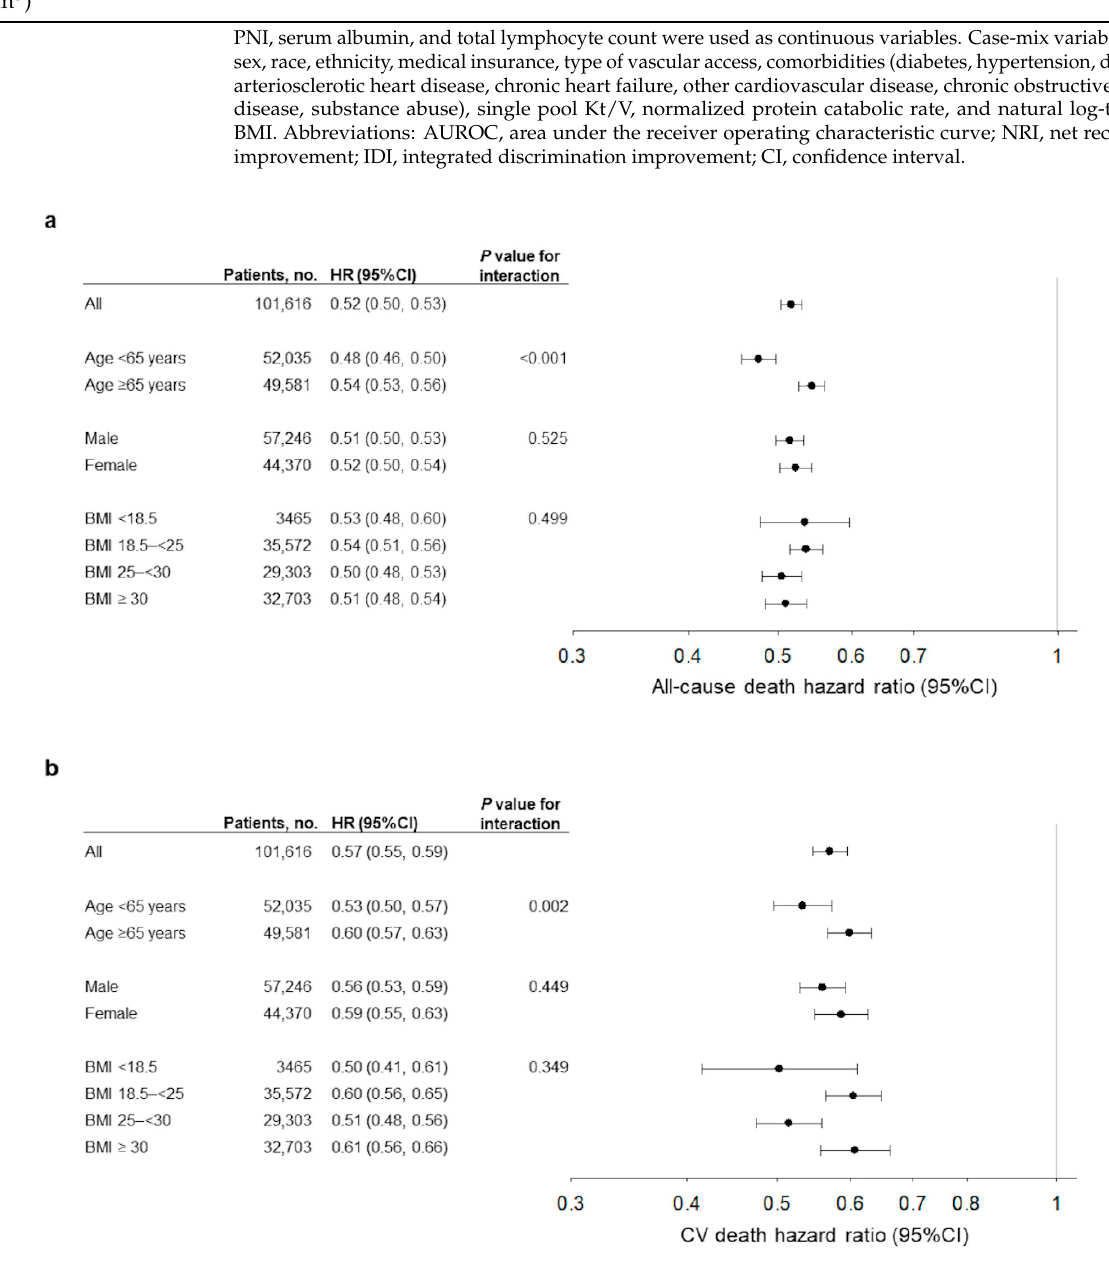
Figure 4. Association of prognostic nutritional index (PNI) with all-cause ( a ) and cardiovascular mortalities ( b ) in the subgroup analysis. Hazard ratios for mortality in the case-mix-adjusted Cox regression models are compared between PNI ≥ 39.5 and PNI < 39.5 (reference). Error bars show 95% confidence intervals of hazard ratios. p values for interaction between each subgroup variable and PNI are shown. Abbreviations: HR, hazard ratio; CI, confidence interval; CV, cardiovascular; BMI, body mass index.